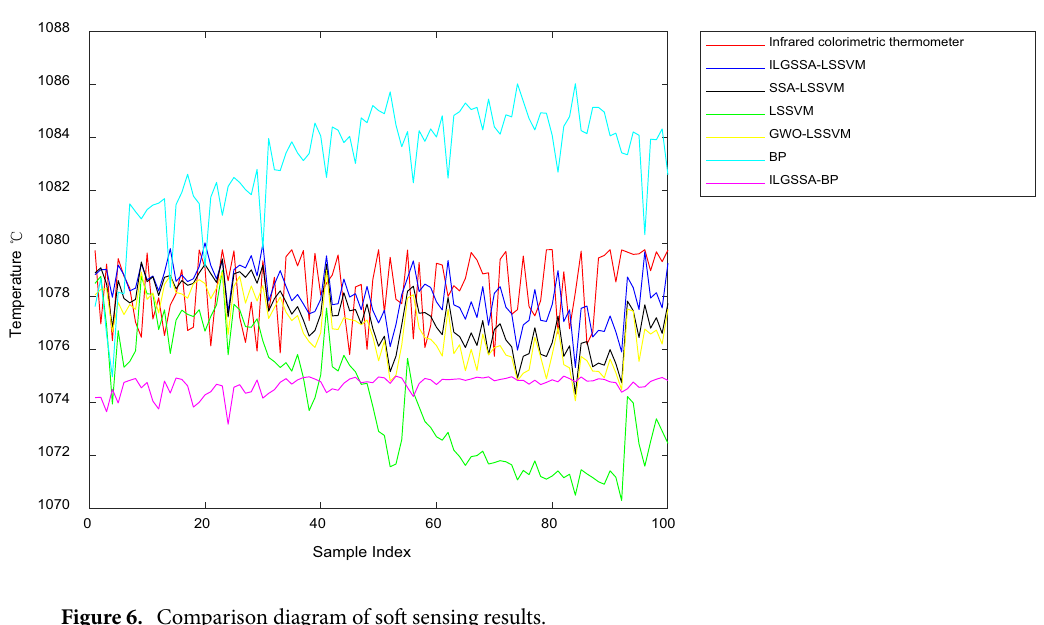
Table1. Comparison table of soft sensing results.